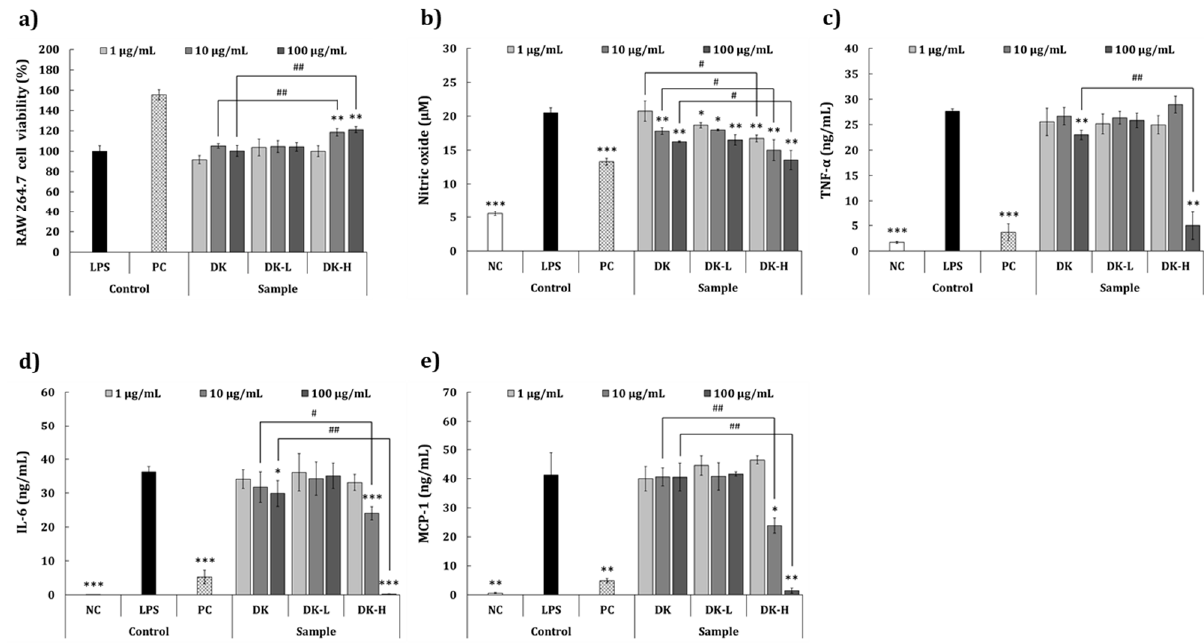
Figure 2. Effects of the fractions isolated from persimmon fruit on the ( a ) viability of RAW 264.7 cells and inhibition of ( b ) nitric oxide, ( c ) tumor necrosis factor-alpha, ( d ) interleukin-6, and ( e ) monocyte chemoattractant protein-1 production in LPS-induced RAW 264.7 cells. Culture medium and lipopolysaccharide (LPS; 1 μ g/mL) were used as a negative control (NC) and inflammation-induced control (LPS), respectively. Treatment with dexamethasone (20 μ g/mL) followed by LPS induction was used as a positive control (PC). DK, DK-L, and DK-H refer to D. kaki extract and its low- and high-molecular- weight fractions, respectively. Statistical differences between the groups were analyzed by Student’s t -test. Asterisks indicate significant differences between the sample and LPS-treated control. The crosshatch patterns indicate significant differences between DK and DK-H at the same concentrations. * and #, p < 0.05; ** and ##, p < 0.01; ***, p < 0.001.